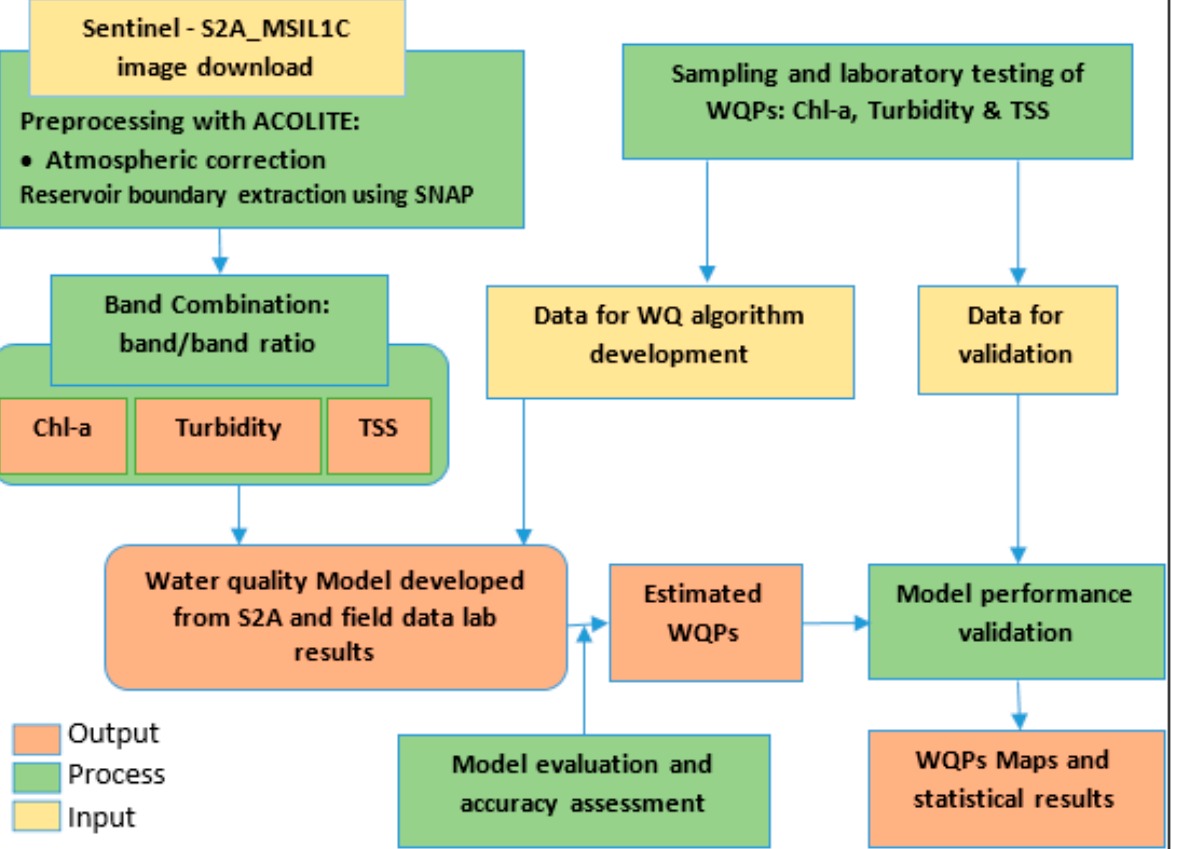
Figure 2. A general framework of WQP model development.